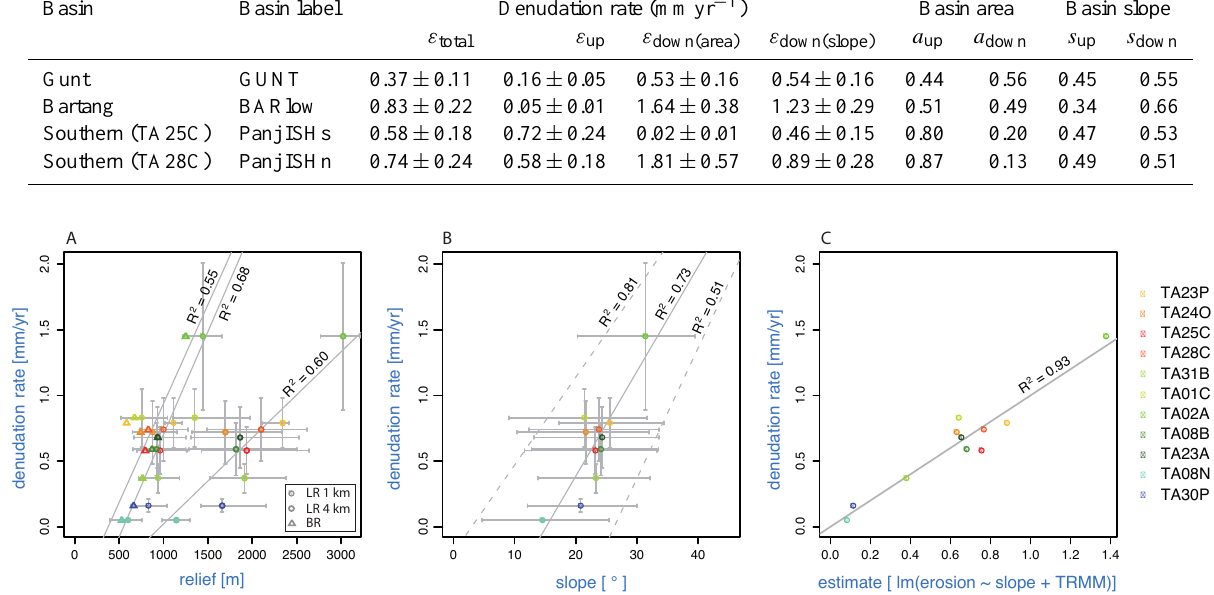
Figure 4. Robust linear regression analyses for denudation rates and the basin parameters relief (a) , slope (b) and slope combined with pre- cipitation (c) . Panel (a) : scale-dependent relief calculation. (BR: basin relief representing the difference between the 0.75 and 0.25 quartiles of basin altitudes; LR: local relief determining the altitude range within moving windows of 1km and 4km. Values of each basin represent the median and the range between the 0.75 and 0.25 quartiles). Panel (b) : basin slopes representing the median of slopes within individual basins. Slope variations are shown according to the 0.25 and 0.75 quartiles. Panel (c) : multiple linear regression revealed highest correlation of denudation rates with the 0.75 quartiles of basin slope and TRMM-based precipitation (lm: linear model used for multiple linear regression analyses). Solid lines show the robust linear regression for median values, dashed lines that of respective quartiles. R 2 gives the coefficient of